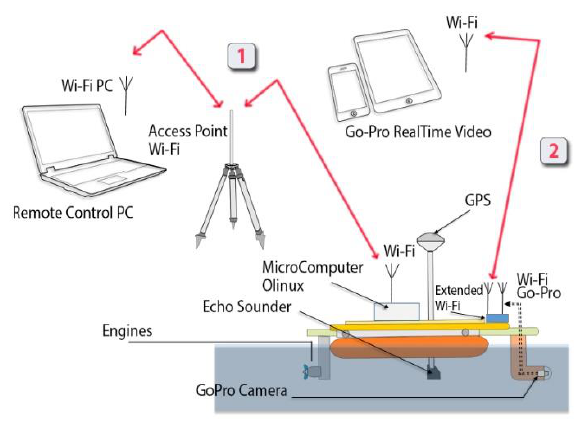
Figure 6. Data transmission system of MicroVeGA